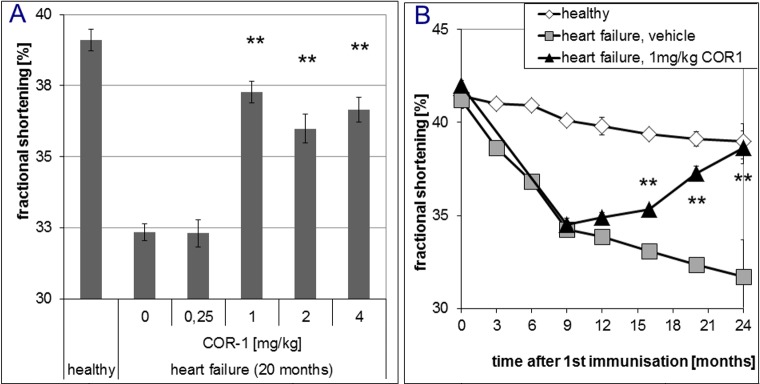
Effects of COR-1 on the fractional shortening (FS) of rats with HF induced by immunisation with GST-ß1EC2 fusion proteins.A: Effects of COR-1 on the FS after ten treatments (in the 20th month after the first immunization), as determined by echocardiography. Mean FS with SEMs are shown for the vehicle control group (n = 8) compared to the ß1EC2HF groups treated with 0.25 (n = 4), 1 (n = 20), 2 (n = 5) or 4 mg/kg BW COR-1 (n = 9), respectively. For comparison, mean FS are also shown for healthy control rats(n = 9). ** indicates strong statistical significance (p<0.005) compared to the HF vehicle control group. B: Time course of the fractional shortening (FS), as determined at intervals of three months. Mean FS with SEMs of healthy rats (white diamonds) and of HF rats treated with vehicle (grey squares)every four weeks starting 10.5 months after the first immunisation, or with 1 mg/kg BW COR-1 (black triangles). At least four animals were analyzed independently per group and time point. *indicate statistical significance (p<0.05) and **indicate strong statistical significance (p<0.005), respectively, when compared to the HF vehicle group.